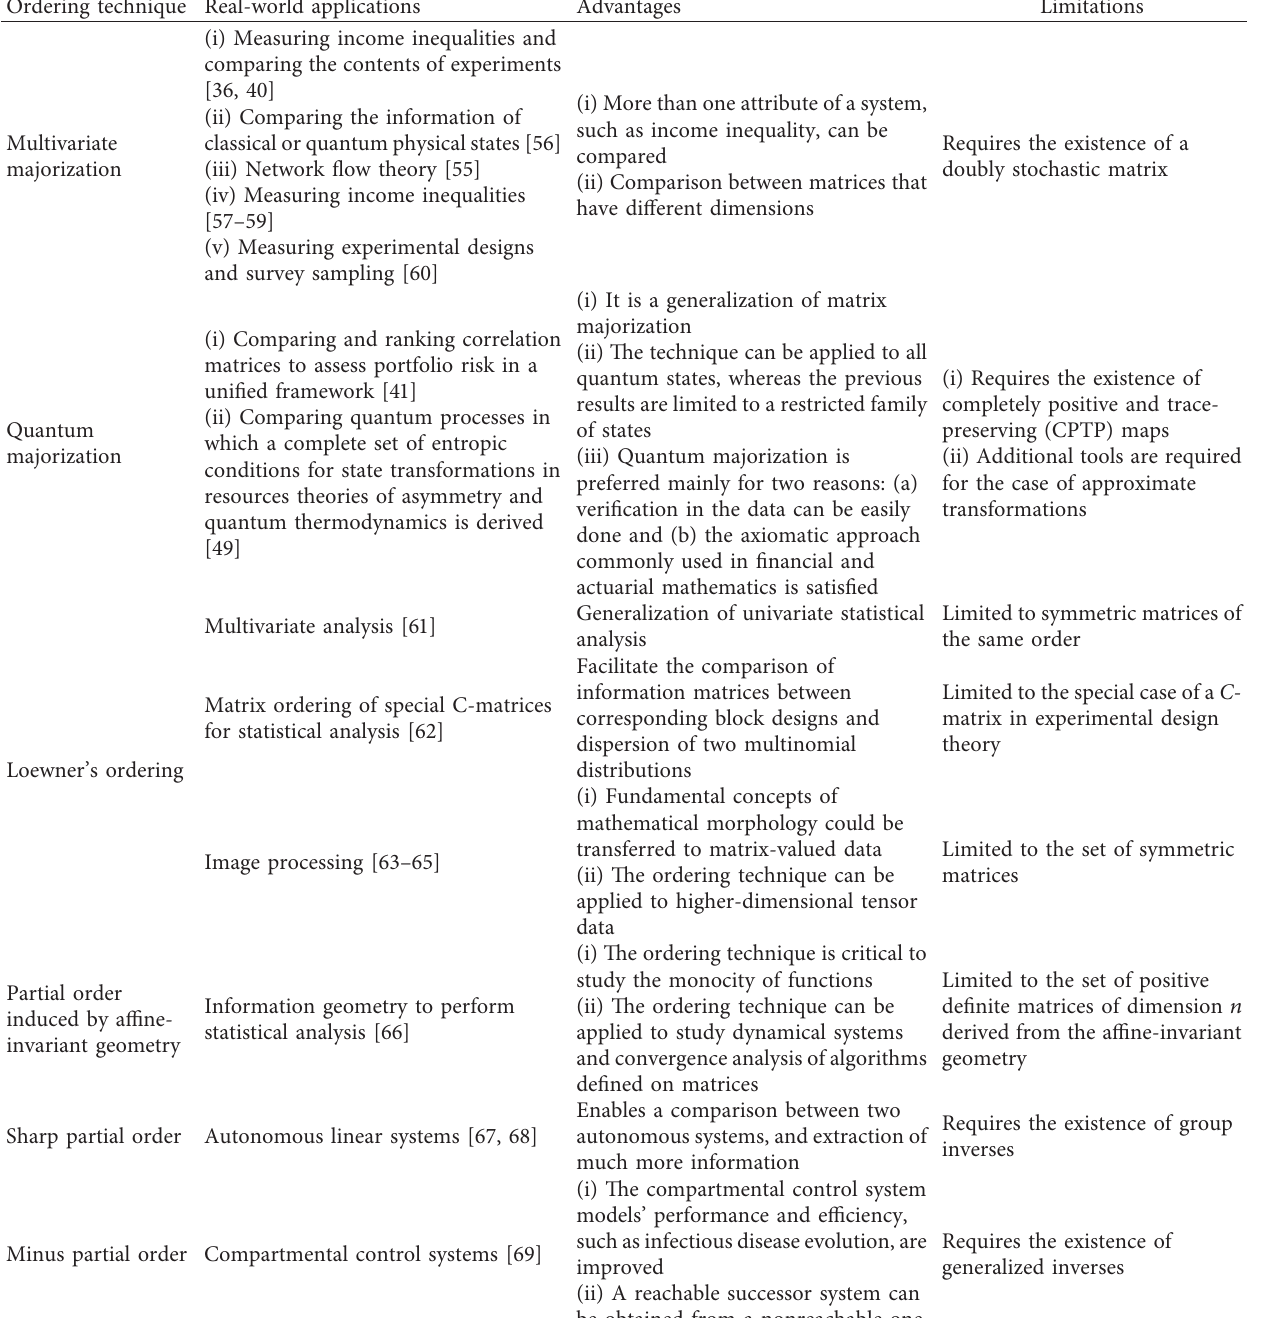
Table 1: Summary of the techniques of ordering matrices available in the literature. Ordering technique Real-world